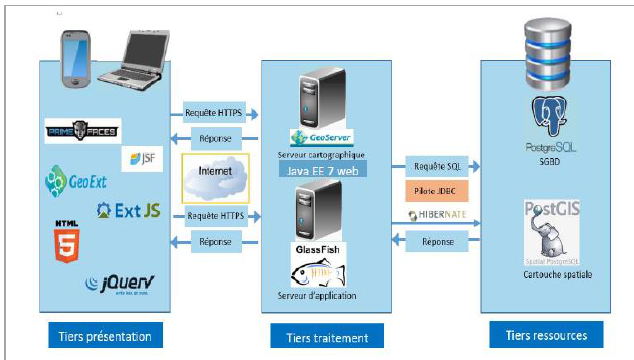
Figure 3. Software architecture of data management subsystem